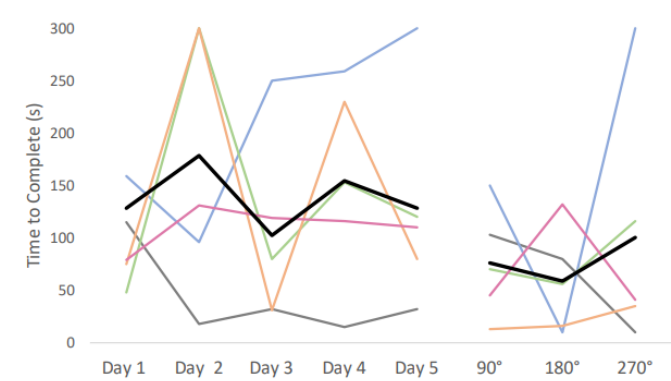
Time (in seconds) for each Turtle to Complete the Detour Problem Each Day